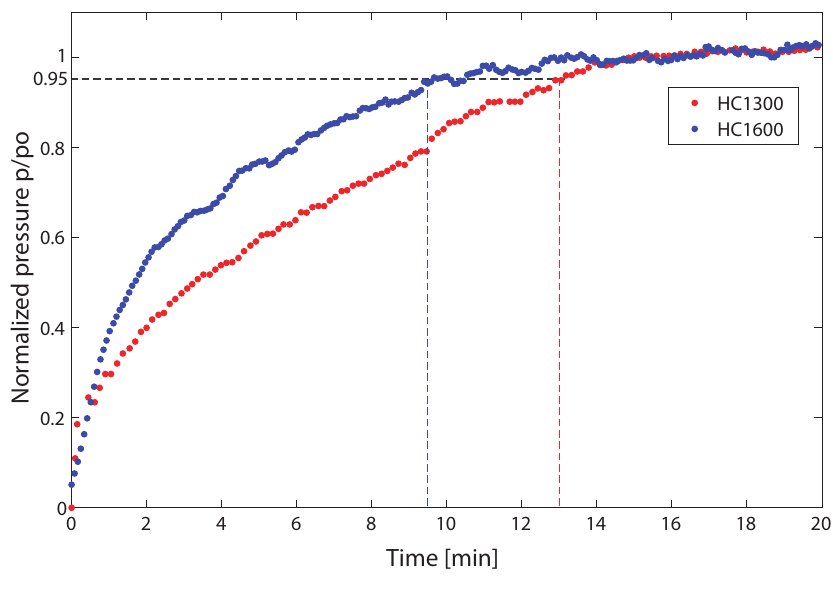
Figure 7. Measured filling process of the HC1300 (red dots) and HC1600 (blue dots) fibres as a function of time. The filling time is indicated with dashed